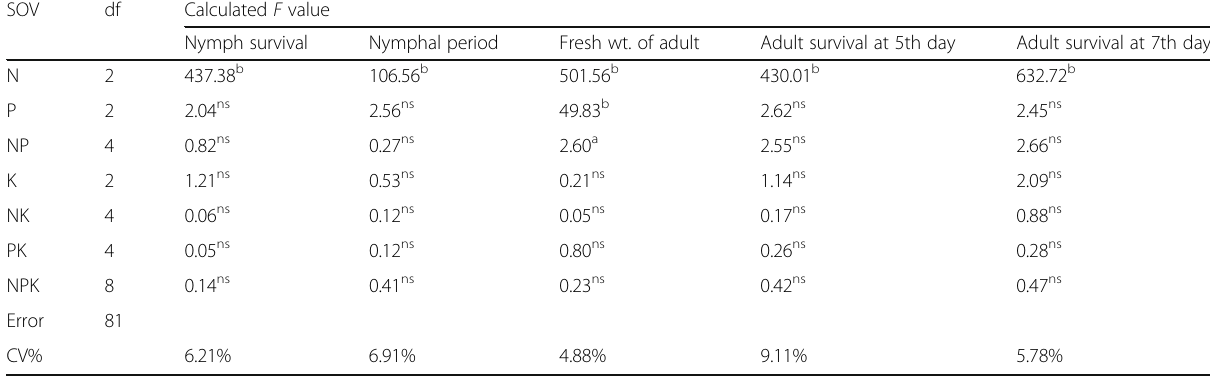
Table 1 Results of three-way analysis of variance (ANOVA) for survival and development of Nilaparvata lugens regarding N, P, and K fertilization SOV df